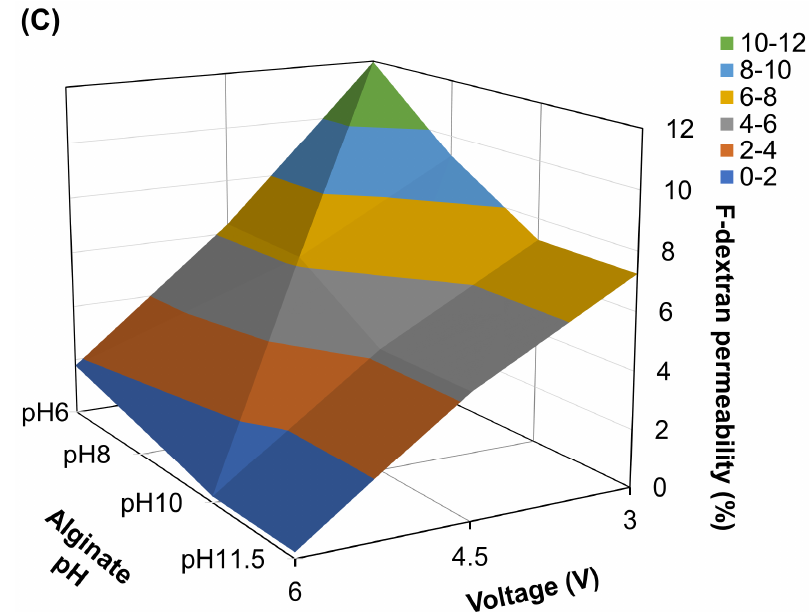
Figure 4. Permeability tests of chitosan membranes. ( A ) Experimental setup of permeability tests. Fluorescence-labeled dextran (F-dextran) was continuously introduced to the upper channel while the lower channel was filled with PBS for 30 min. The percentage of F-dextran that passed through the chitosan membrane was determined by dividing the fluorescence intensity within the blue box (sink) by the fluorescence intensity within the black box (source). ( B ) The zoomed-in images of chitosan membranes, outlined with white dashed lines, under permeability with F-dextran. Chitosan membranes were fabricated at ( i ) fixed voltage (3 V) while varying the pH of alginate or ( ii ) fixed pH of alginate of 11.5 while changing the voltage or fabrication method. ( C ) The permeable percentage of F-dextran across chitosan membranes fabricated under different conditions.